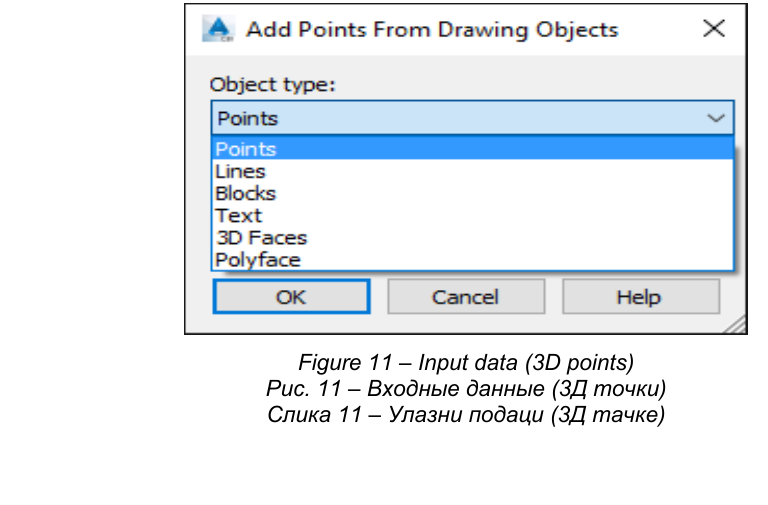
Figure 11 – Input data (3D points) Рис . 11 – Входные данные (3 Д точки ) Слика 11 – Улазни подаци (3 Д тачке